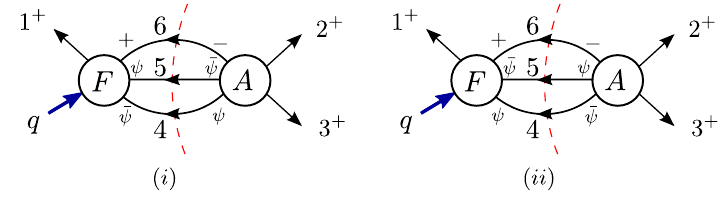
Figure 11 . Triple cut of the two-loop form factor in the s 23 -channel | fermions and a gluon running in the loop, the (cid:12)rst possible